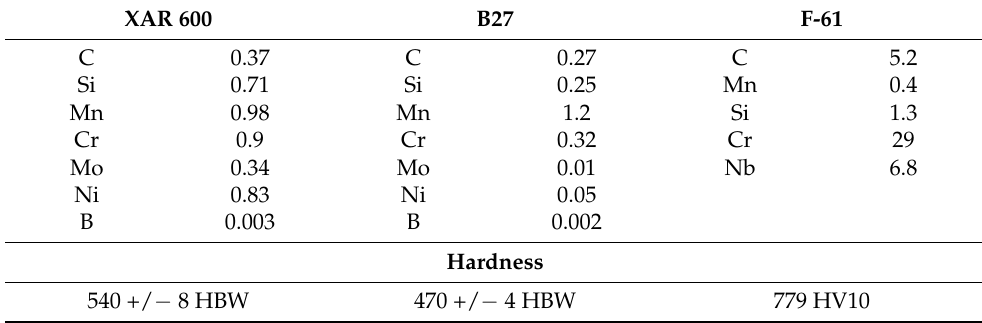
Figure 5. 38GSA steel microstructure—fine dispersed perlite with grains of ferrite and martensite. Magnitude 500×, etched with 3% HNO 3 (Mi1Fe). Table 4. Characteristics of the chemical composition of the top layers of materials taken for